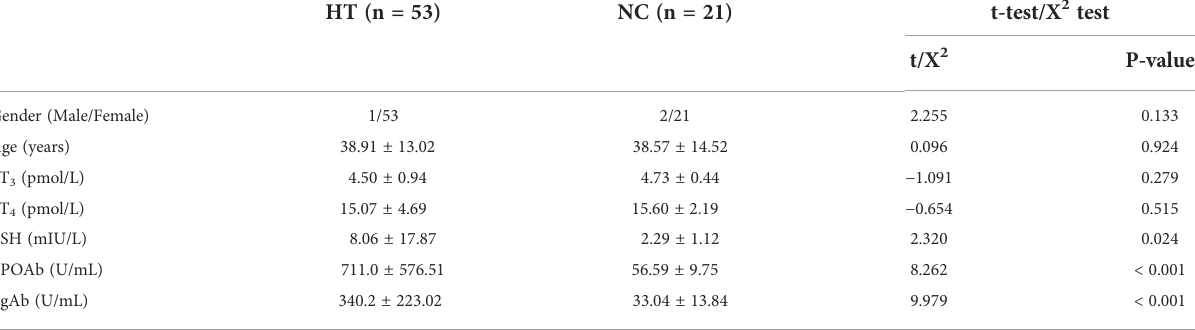
TABLE 1 Comparison of the clinical data from the HT and the NC